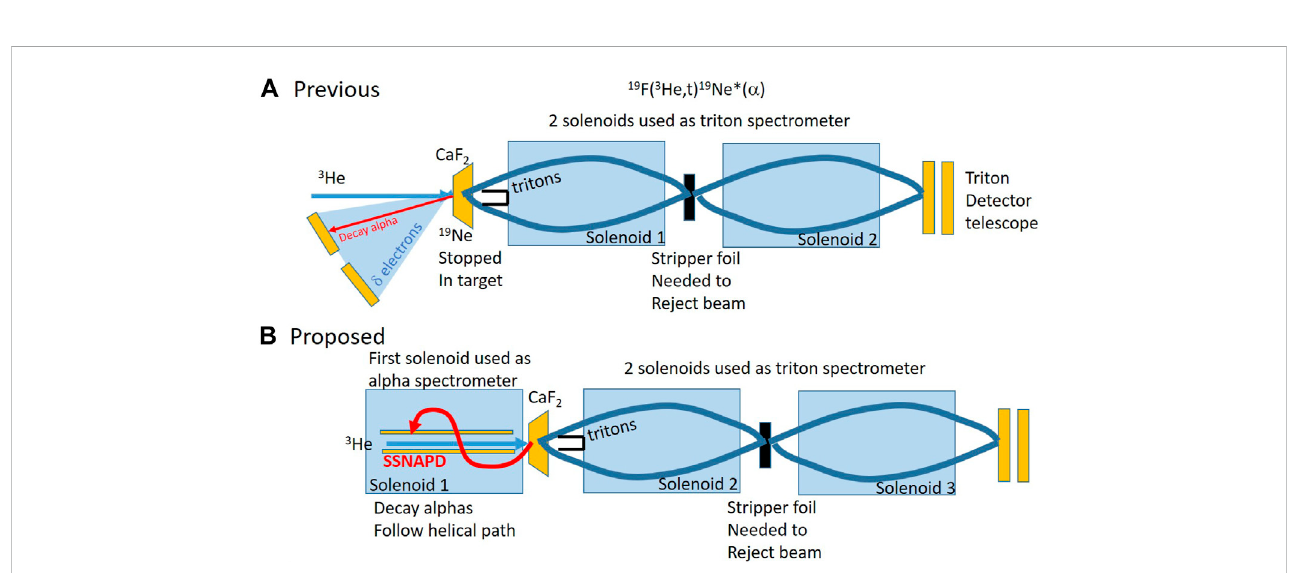
FIGURE 5 (A) The α widths of 19 Ne levels were previously measured [27] utilizing the 19 F( 3 He, t ) 19 Ne reaction. Tritons populating 19 Ne levels were separated by the TwinSol separator in coincidence with decay α particles detected in Si detectors. (B) The SSNAPD detector would alleviate background coming from the blinding rate of δ electrons hitting the Si detector by magnetically analyzing light charged particles leaving the